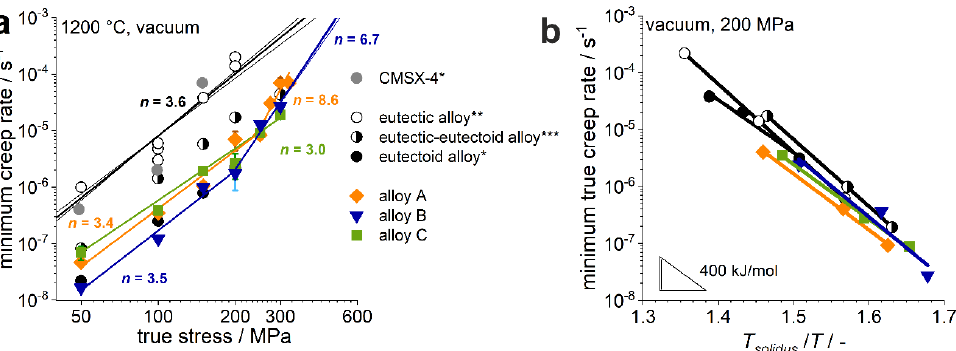
Figure 7. Norton plot ( a ) and by the solidus temperature normalised Arrhenius plot ( b ) of the investigated alloys A to C (colored symbols) in comparison to previously investigated alloys (black/white circular symbols) ( a ). * Data of CMSX-4 taken from [19]. ** Some data of the eutectic alloy taken from [11] and all data on the eutectoid alloy taken from [11], *** and of the eutectic-eutectoid alloy from [10].